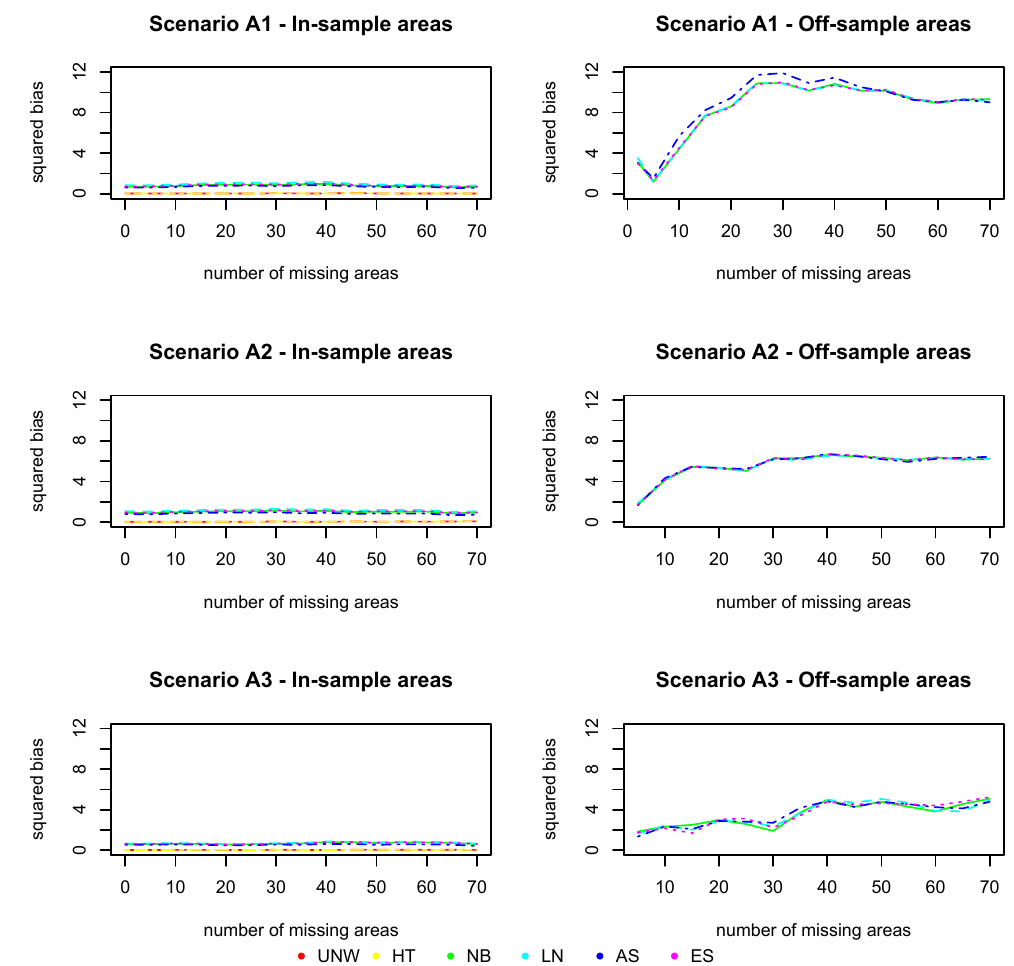
Figure 3. Simulation 1: Squared Bias ( × 10 3 ). UNW = unweighted estimator; HT = Horvitz–Thompson estimator; NB = naive binomial model; LN = logit-normal model; AS = arcsine model; ES = effective sample size model. ( A 1 ) : σ 2 v = 0.15 and σ 2 u = 0.03; ( A 2 ) : σ 2 v = 0.09 and σ 2 u = 0.09; ( A 3 ) : σ 2 v = 0.03 and σ 2 u =